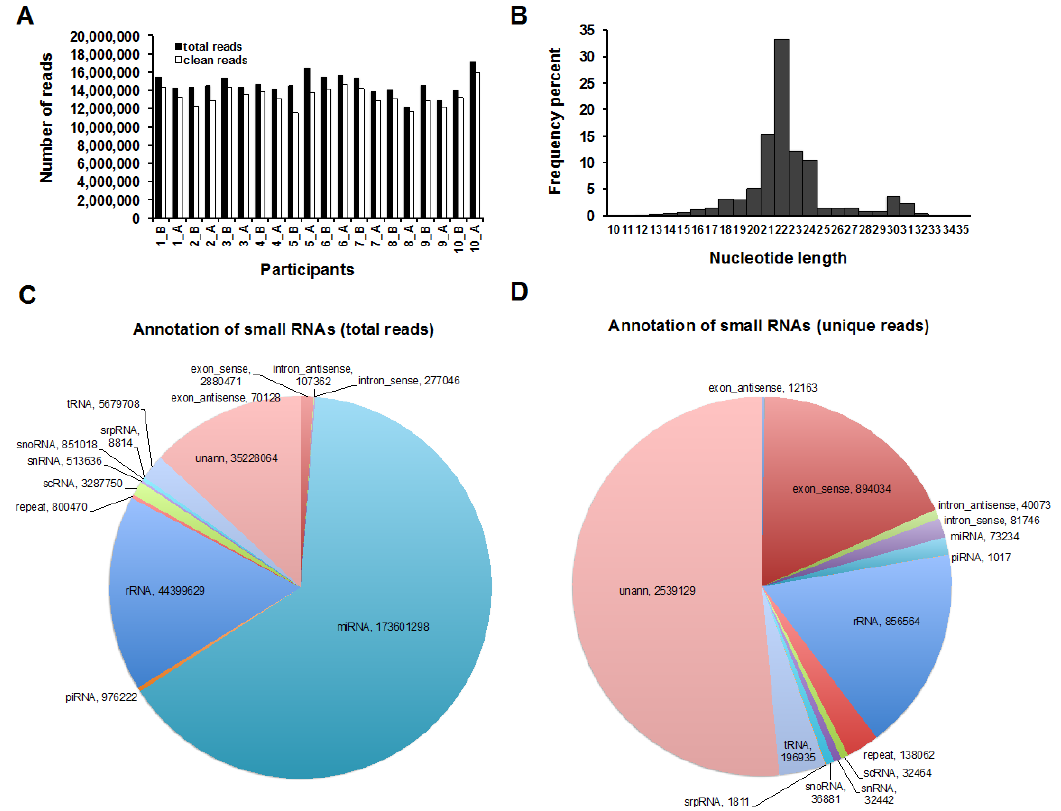
Figure 1. Filtering and annotation of the small RNA reads. ( A ) The total number of small RNA raw reads including miRNAs, and the total number of clean reads that were generated after filter analysis; ( B ) Percentage of the nucleotide length distribution of clean small RNAs after filter analysis; ( C ) Total clean reads were annotated to one or more RNA categories ( i.e. rRNA, tRNA, scRNA etc. ); ( D ) Small RNAs were mapped to only one RNA category using the following priority rule: rRNAetc (in which Genbank > Rfam) > known miRNA > piRNA > repeat > exon > intron3. rRNAs were used as a marker of sample quality, with the criterion of high quality when <40% in each sample.